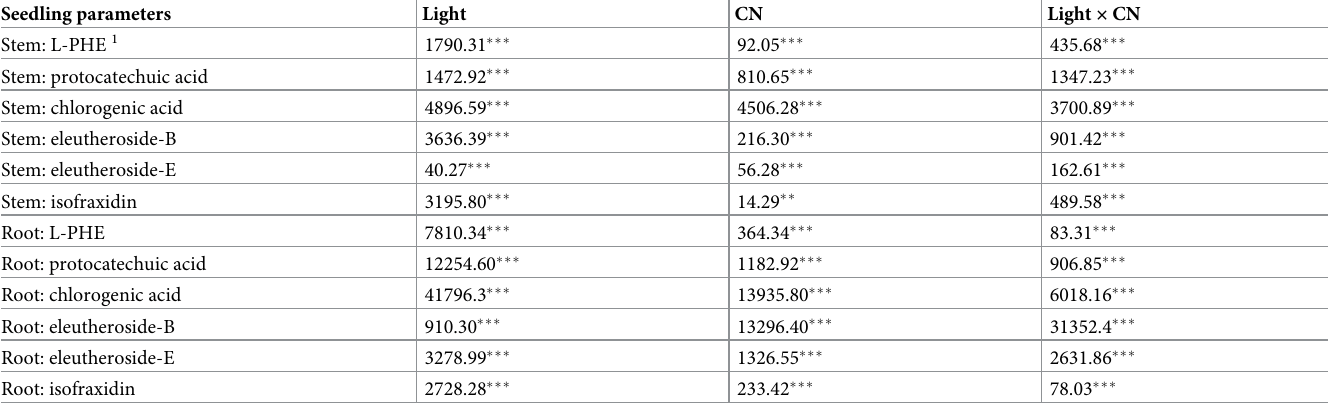
Table 4. F values from analysis of variance (ANOVA) of effects of light quality (Light), chitosan nanoparticle addition (CN), and their interaction (Light × CN) on bioactive compounds in stems and roots of Eleutherococcus senticosus seedlings. Seedling